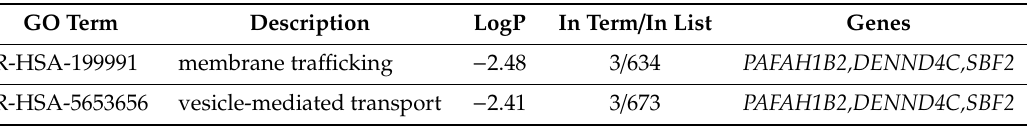
Table 5. Metascape functional annotation clusters for downregulated genes in embryos treated with FoEVs compared to